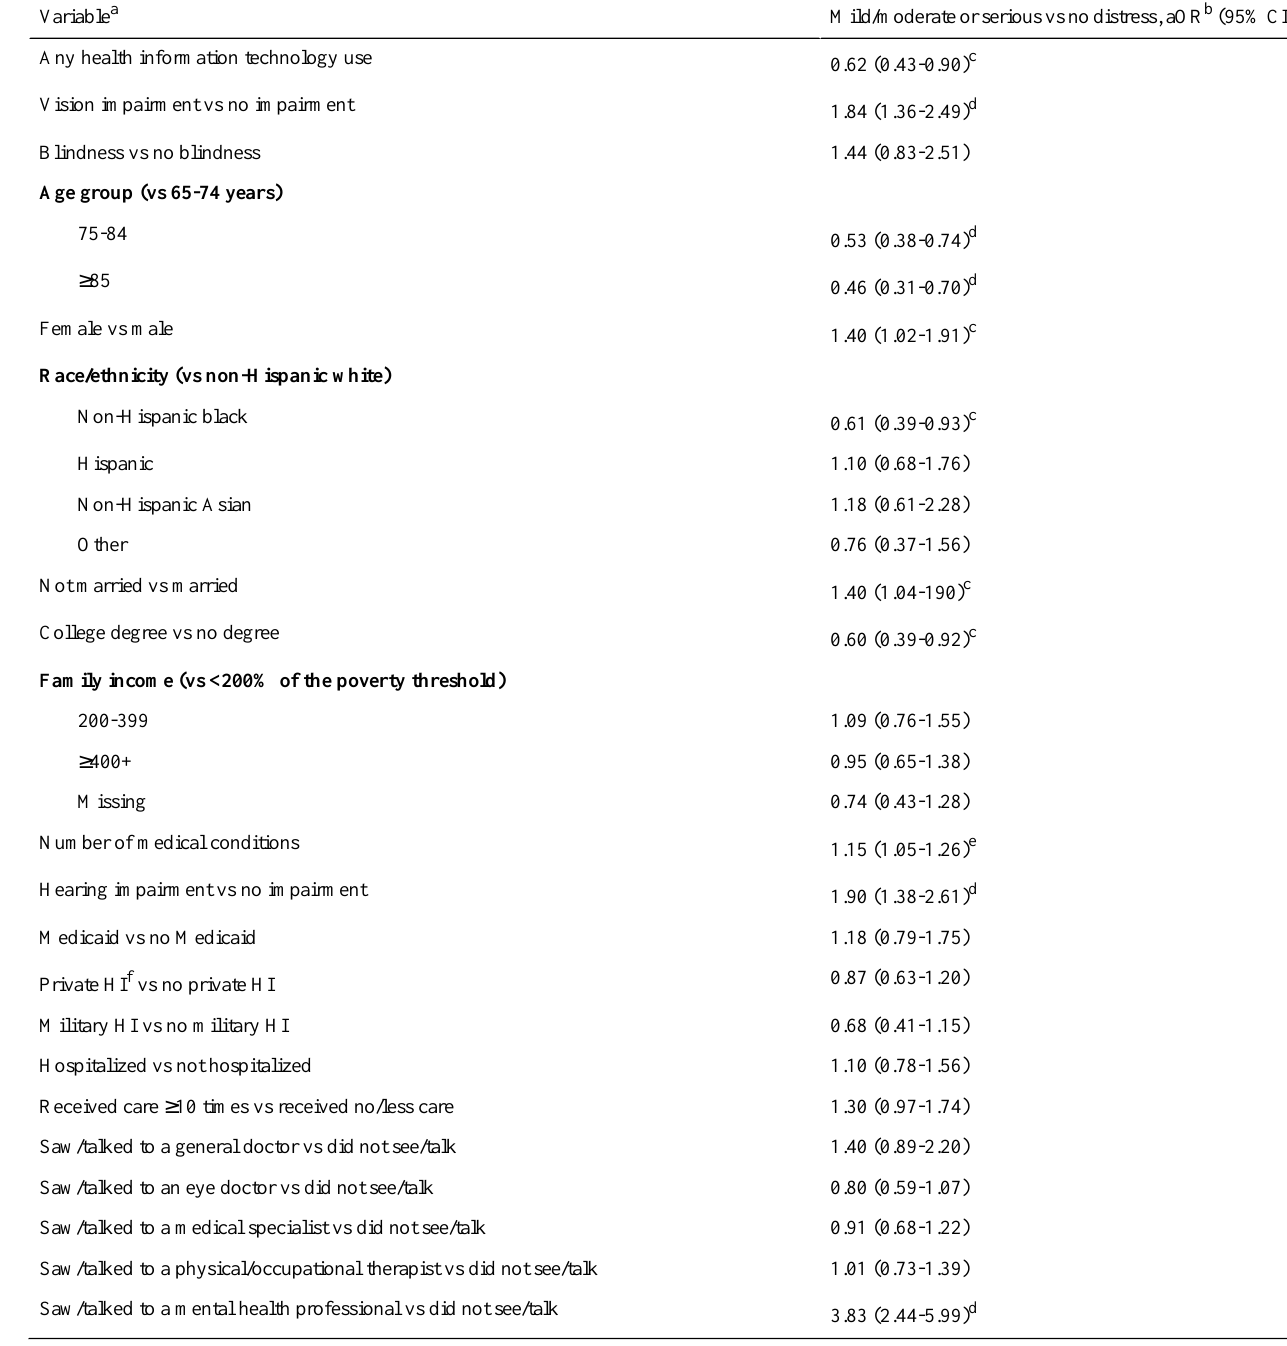
Table 4. Association of any health information technology use with psychological distress: logistic regression